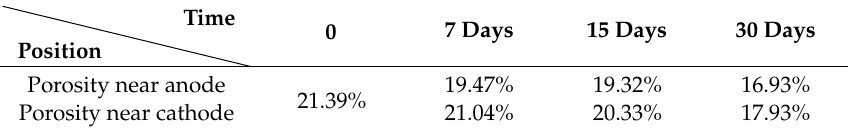
Table 5. Porosity changes after BIEM